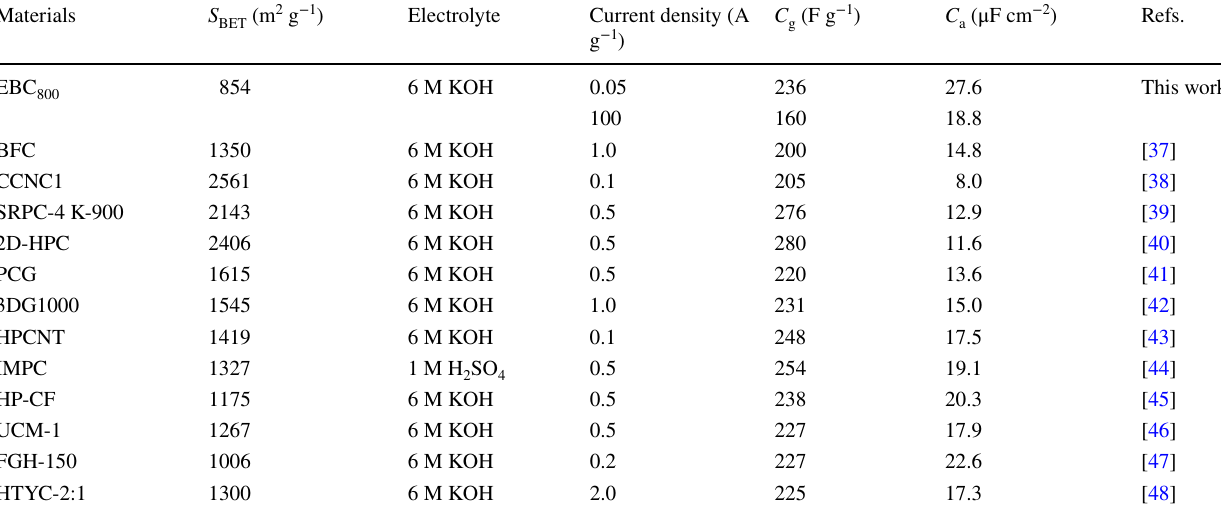
Table 2 Comparison of the gravimetric and areal capacitance of EBC 800 electrode with reported carbon-based electrodes